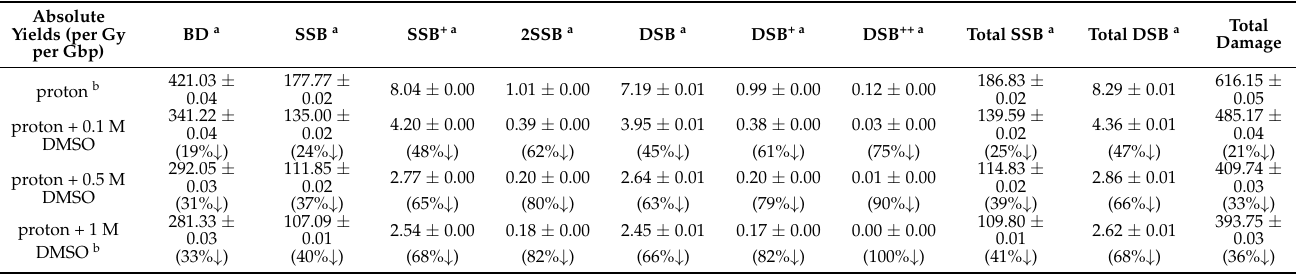
Table 1. Absolute Yields of Double Strand Break (DSB) Inductions for Cells Irradiated with Proton Ions (Linear Energy Transfer (LET) = 1.051 keV/ µ m) in the Presence of Various Concentrations of DMSO. Absolute BD Yields (per Gy per Gbp)